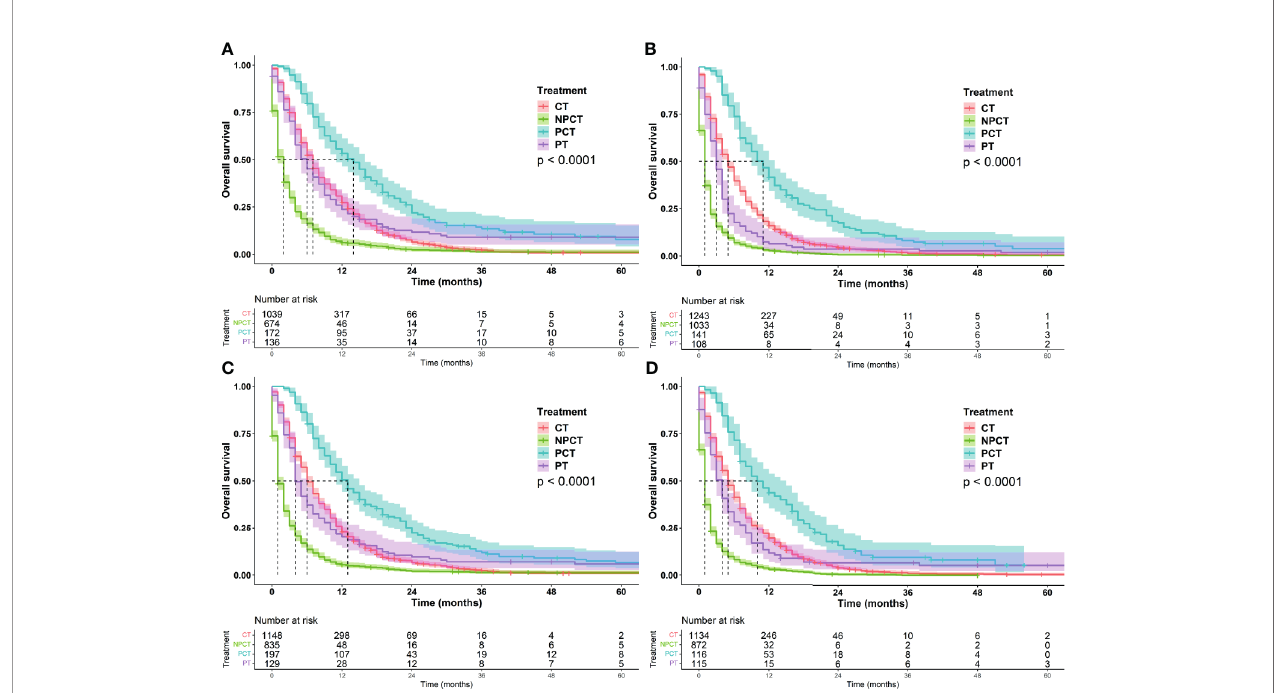
FIGURE 4 | Kaplan-Meier survival curves for subgroup analysis of patients with metastatic pancreatic cancer with different tumor characteristics. (A) grade: well/ moderately differentiated (B) grade: Poor/Undifferentiated, (C) : tumor size ≤ 42mm, (D) : tumor